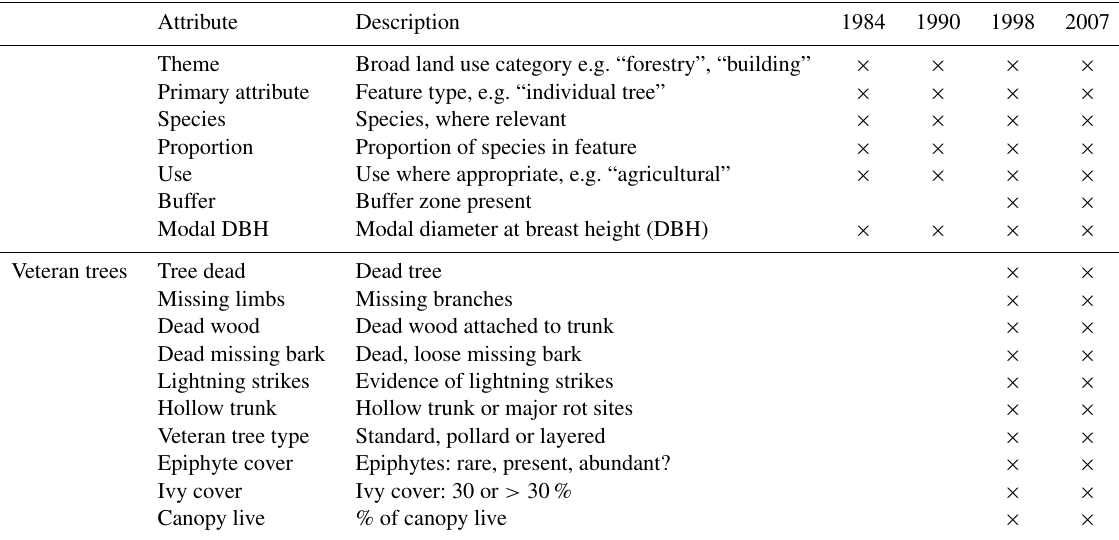
Line of stumps Vertical gappiness Margin width left Margin width right Species composition Species Proportion